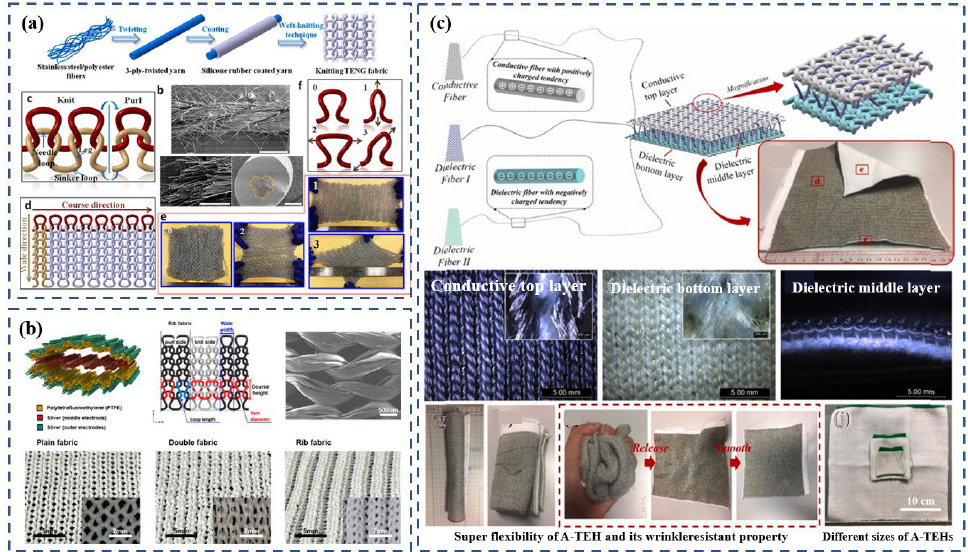
Figure 5. ( a ) Knitted-structure generator based on 1D devices. Reproduced with permission [77]. Copyright 2017, American Chemical Society. ( b ) Knitted-structure generator based on two kinds of 1D electrodes. Reproduced with permission [78]. Copyright 2017, American Chemical Society. ( c ) Schematic illustration of the realization of the energy-harvesting mode as 3D full-fabric structural integrity using all fiber materials by a computerized knitting programming and loop structures. Reproduced with permission [41]. Copyright 2019, Elsevier.